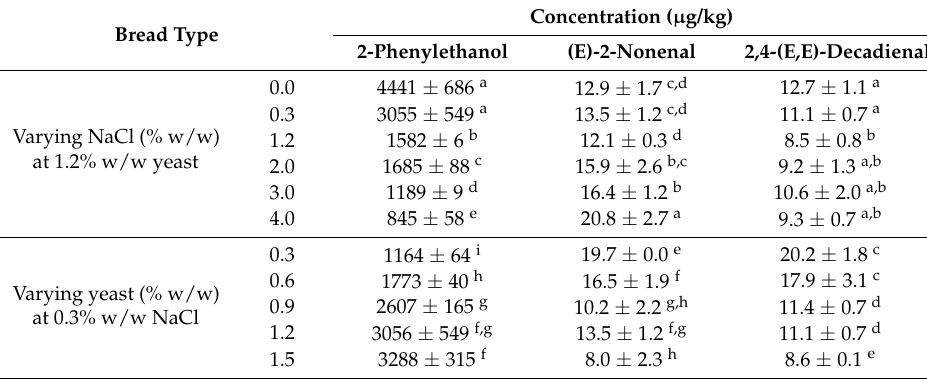
Table 4. Concentration of 2-phenylethanol, (E)-2-nonenal and 2,4-(E,E)-decadienal in bread-crumb samples as determined by 2D-HRGC-MS. Concentration ( µ g/kg) Bread Type 2-Phenylethanol (E)-2-Nonenal 2,4-(E,E)-Decadienal 0.0 4441 ± 686 Varying NaCl (% w/w) at 1.2% w/w yeast